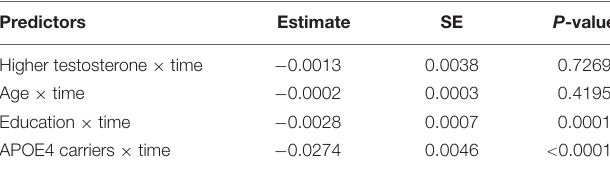
TABLE 3 | Results of linear mixed models in females.